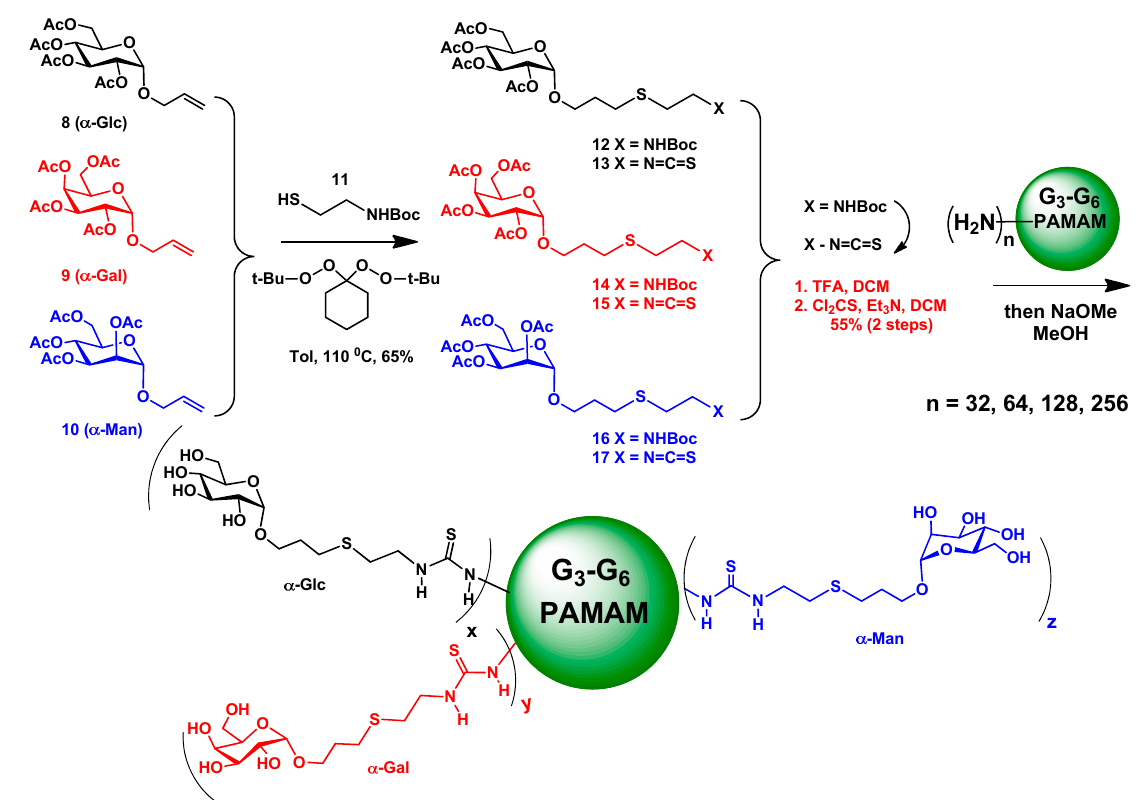
Scheme 1. Synthesis of polyamidoamine (PAMAM)-heteroglycodendrimers containing randomly distributed glucose, galactose, and mannose residues [21,22].